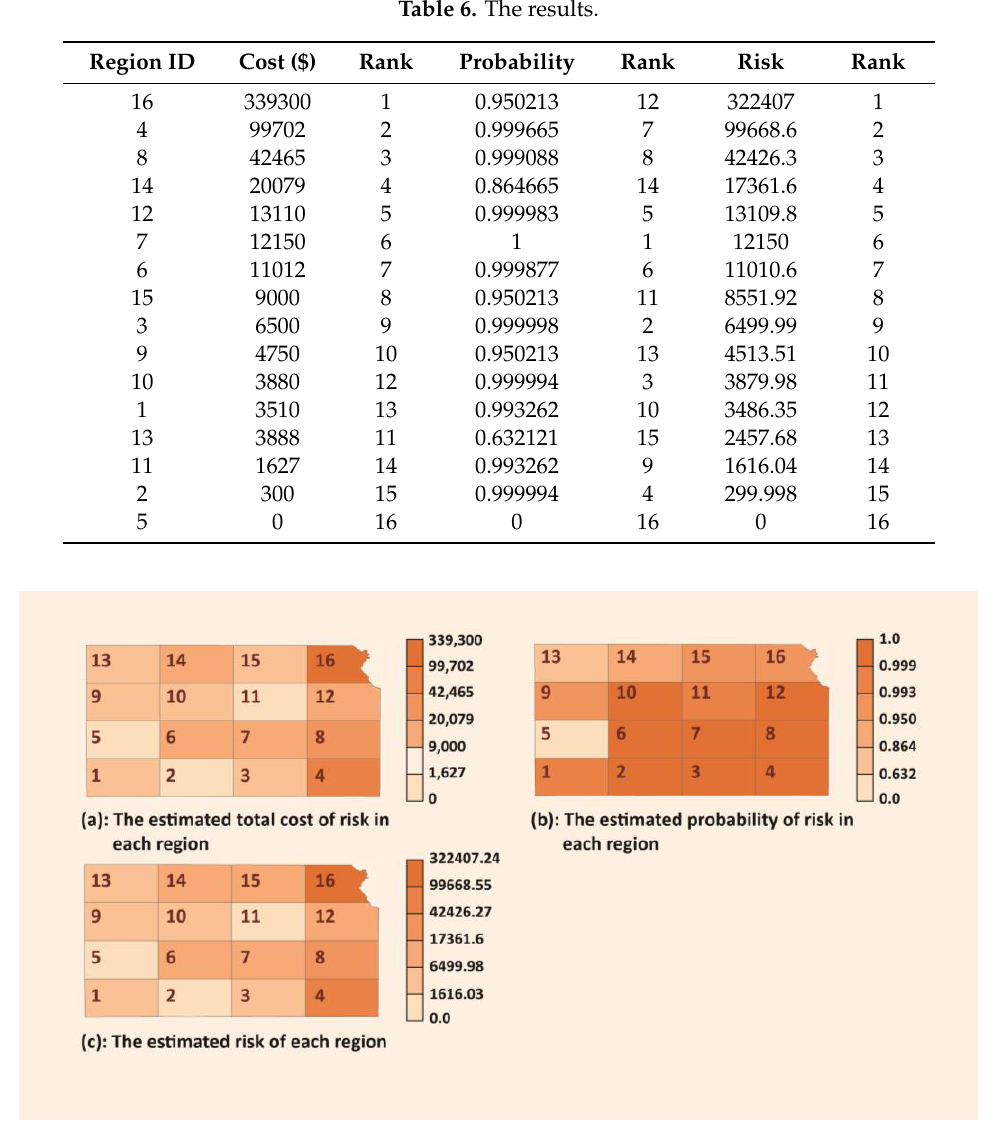
Figure 7. Illustration of the results.